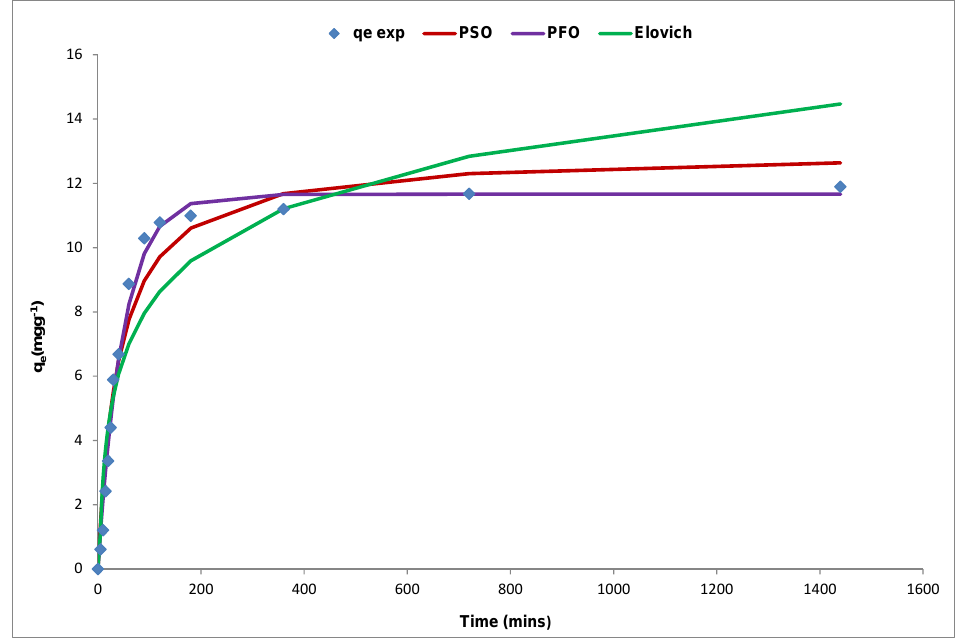
Figure 12. Plot for pseudo first order (PFO), pseudo second order (PSO), and Elovich kinetic models.